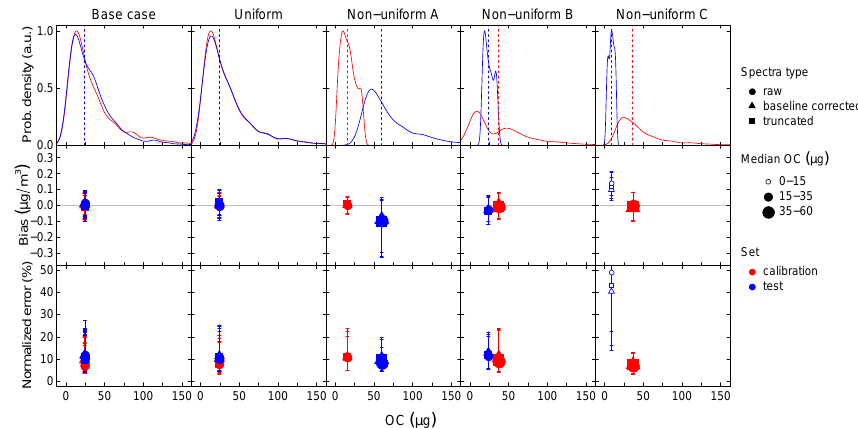
Figure 4. The probability density distribution of OC and bias and normalized error (with the interquartile range shown by error bars) in the calibration (red) and test (blue) sets for five calibration cases: the Base case, the Uniform OC case and three Non-uniform OC cases. Vertical lines are the median of the OC mass distributions color-coded for calibration and test